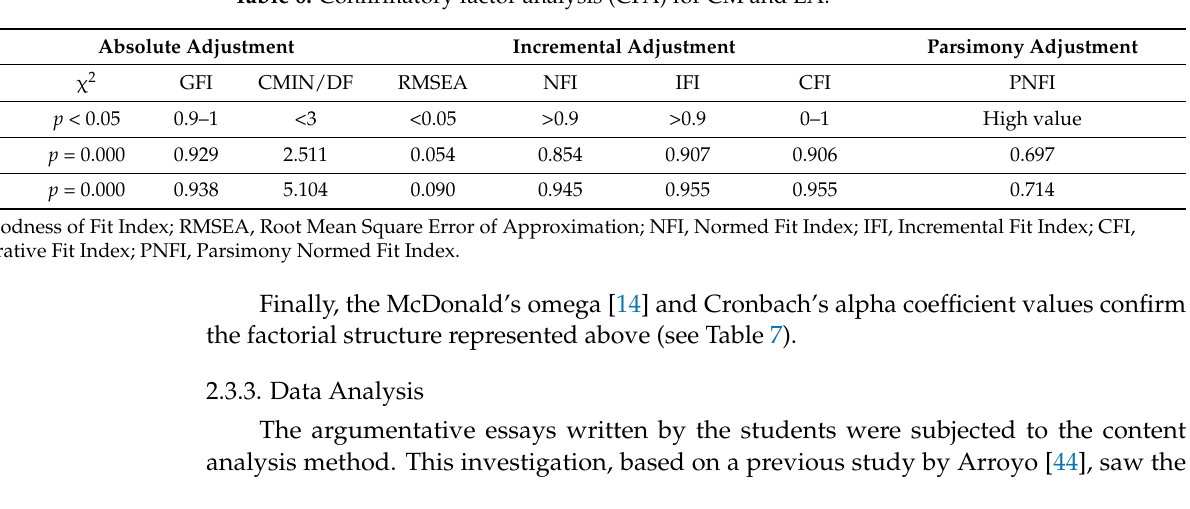
Table 6. Confirmatory factor analysis (CFA) for CM and